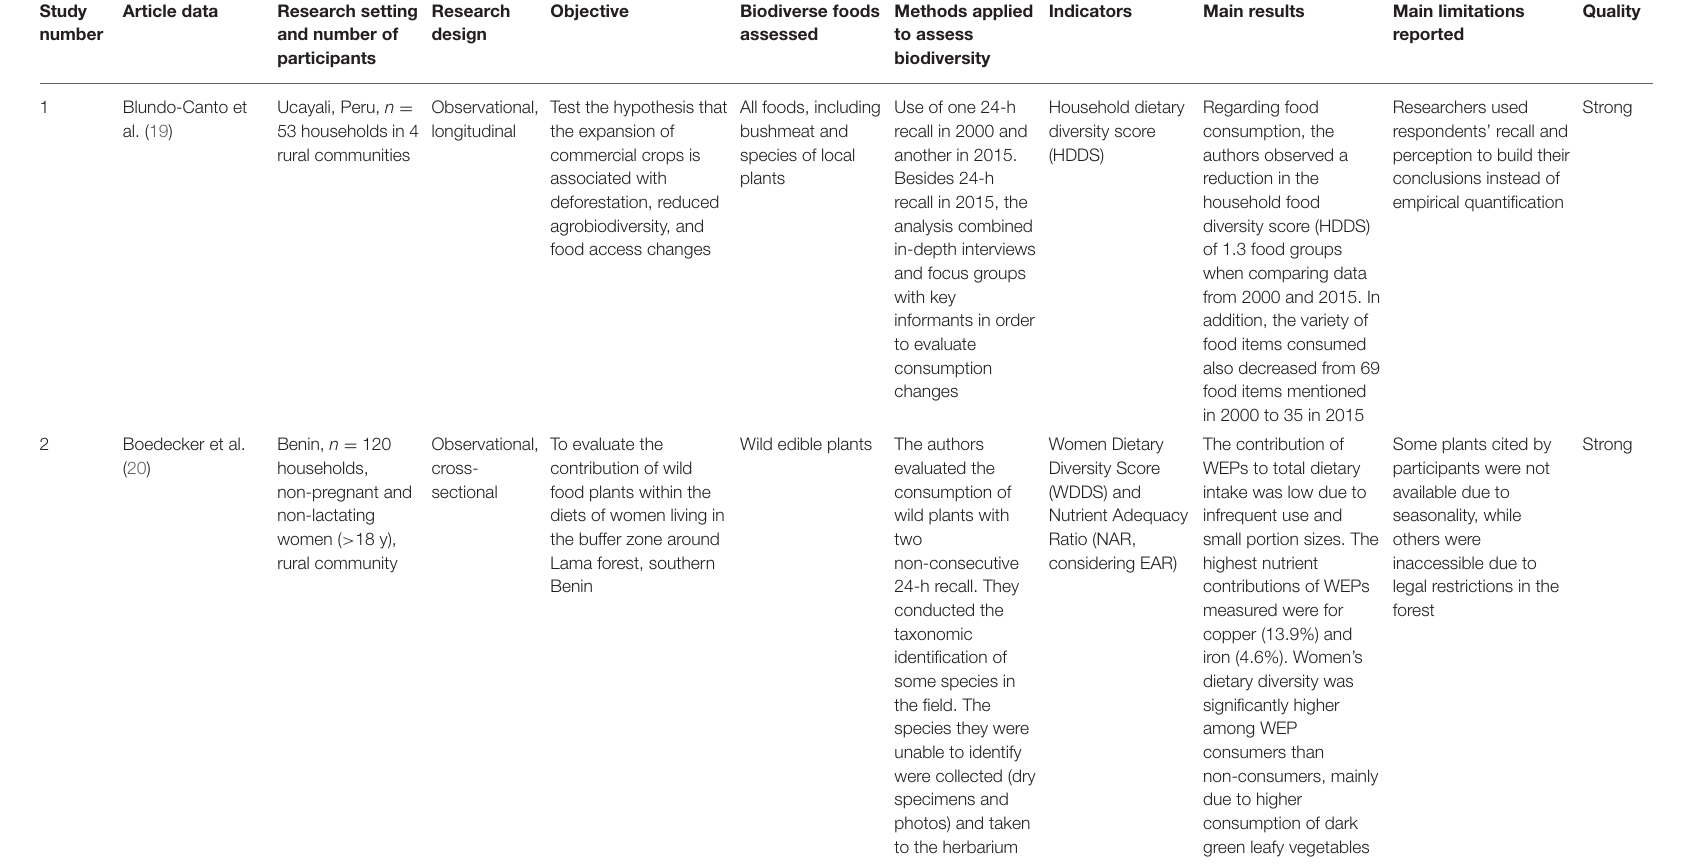
TABLE 1 | Characterization of food consumption studies assessing biodiverse